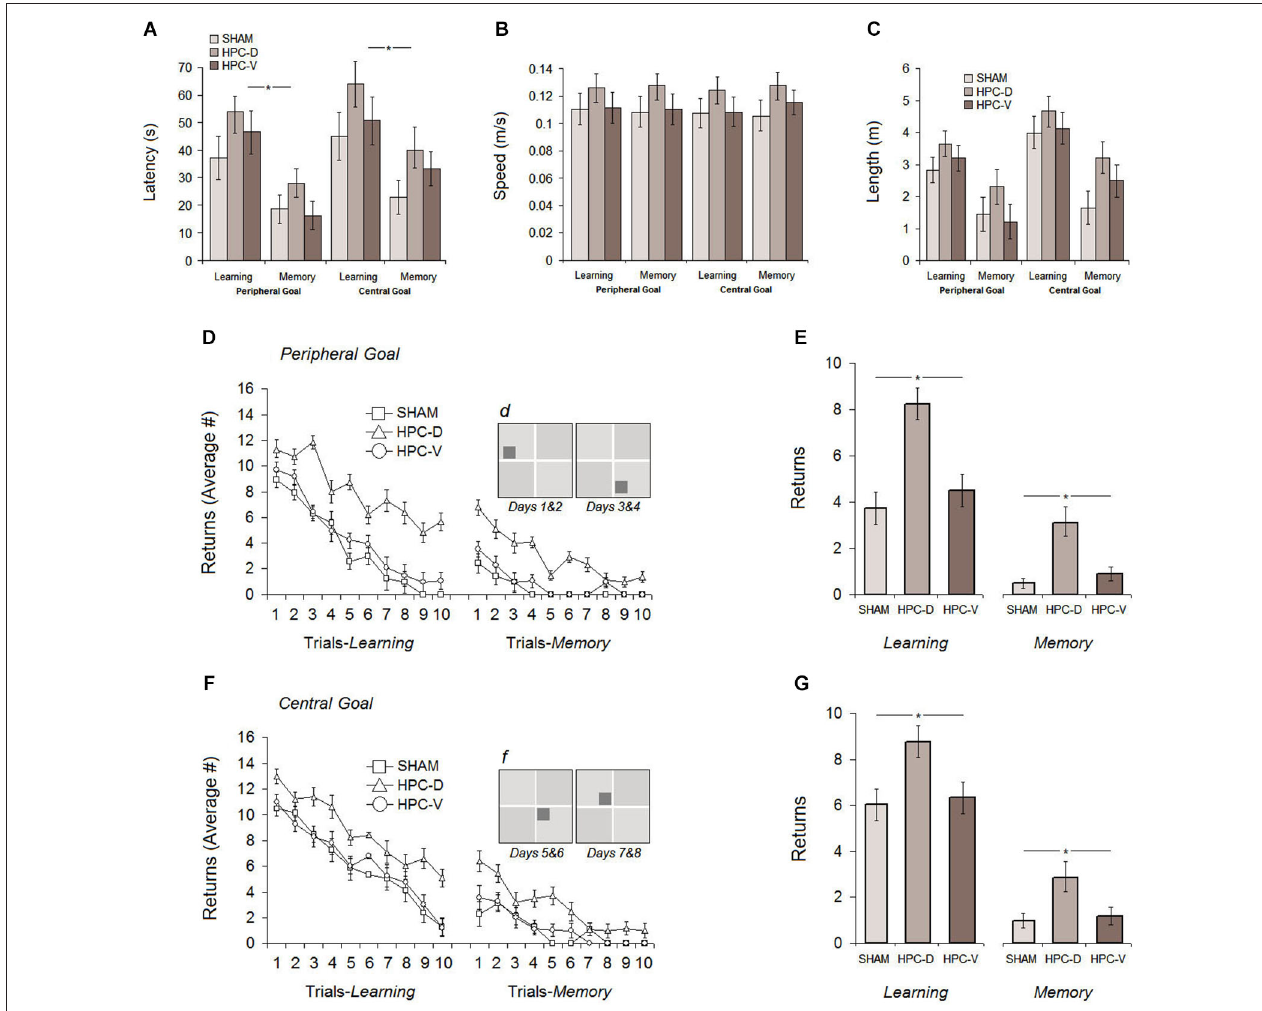
and sham rats on learning and memory days. Note that spatial testing on the first four post-ischemic days (learning and memory) used peripheral goal ziggurats and on the second four post-ischemic days used the central goal ziggurats. Dark gray squares in sub-panels (d) and (f) indicate the location of peripheral and central spatial goals, respectively. * P < 0.05; error bars show ± SEM. HPC-D: dorsal hippocampus; HPC-V: ventral